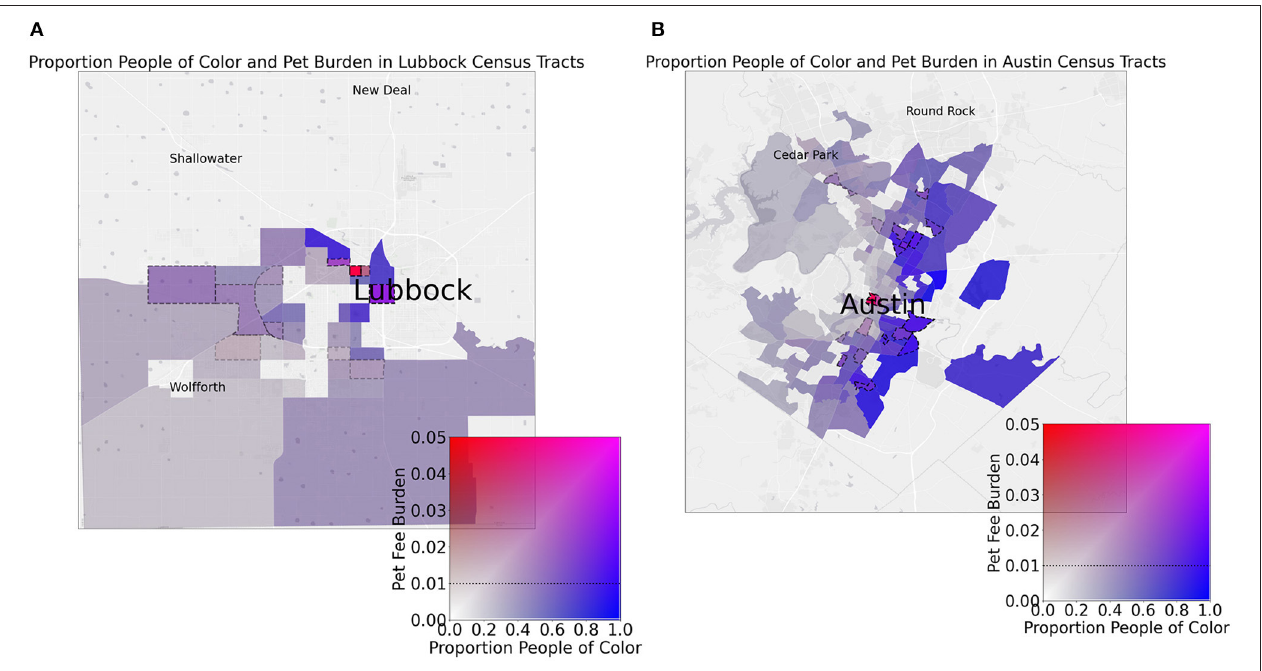
FIGURE 6 | Maps display spatial relationships between census tracts’ proportion of people of color (POC) and pet fee burden in Lubbock (A) and Austin (B) . Dotted lines around tracts indicate a 1% (0.01) or greater pet fee burden. Note that highly blue tracts indicate low burden POC areas while purple regions indicate high burden POC areas. Red indicates high burden, low POC areas while transparent regions have low POC and low burden. It is interesting to note red hotspots at city centers while dotted line regions are typical of a large proportion of high POC